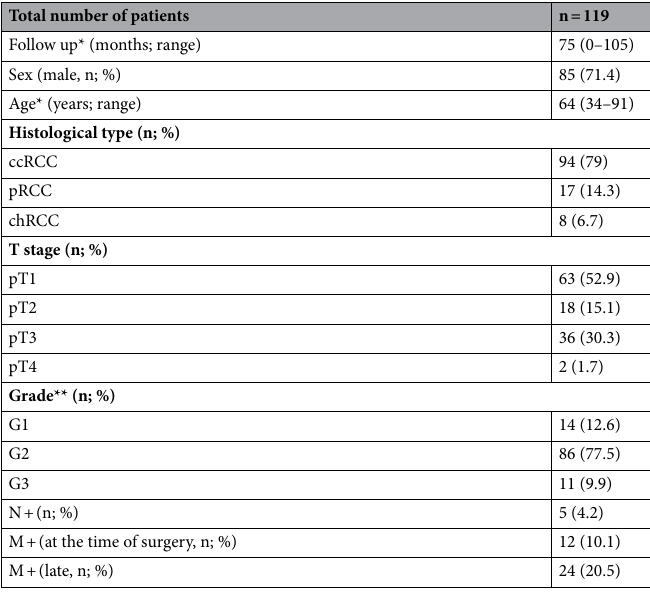
Table 1. Clinicopathological features of the study cohort. *Data are presented as median value (with range in brackets). **According to the current WHO classification, chRCC cannot be graded due to its innate nuclear atypia. Thereby the grading values shown here relate to ccRCC and pRCC